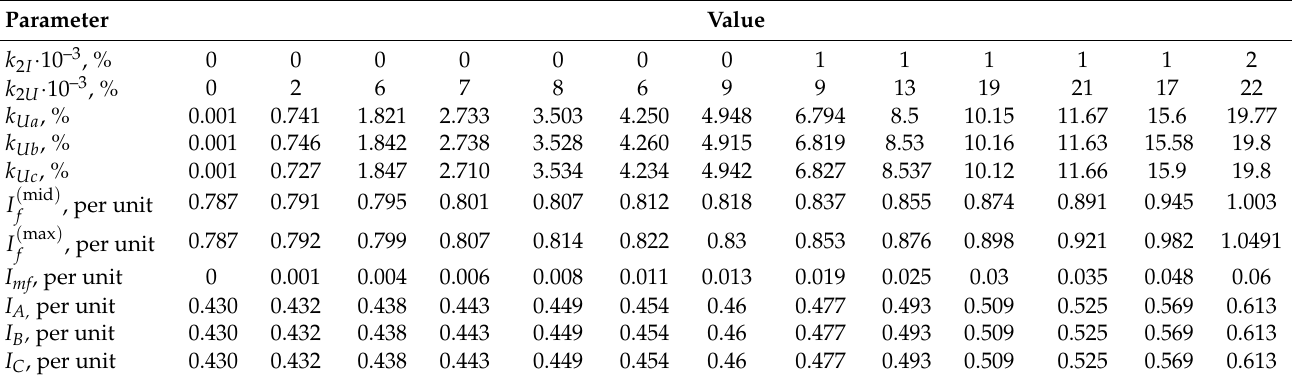
Figure 8. Flow chart of the model of the turbogenerator serving balanced and non-linear loads in MATLAB.